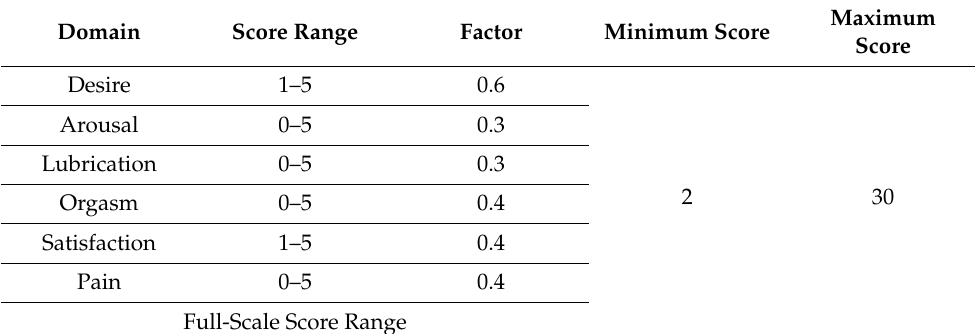
Table 1. Female Sexual Function Index-6 (FSFI-6) Scoring